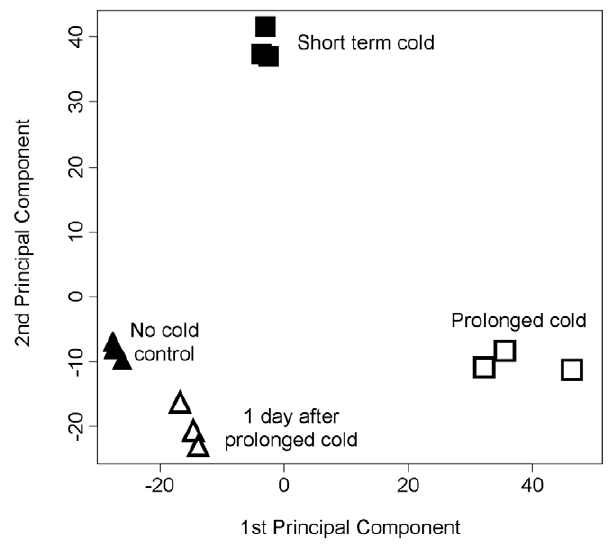
Figure 4. Principle component analysis of microarray data. Principal component analysis was applied to differentially expressed contigs identified in the different seedling treatments (see methods). Closed triangles ( m ) indicate samples from the no cold control treatment. Open triangles ( D ) represent the 1 day after prolonged cold treatment. Closed squares ( & ) represent the short term cold treatment. Open squares ( % ) represent the prolonged cold treatment.